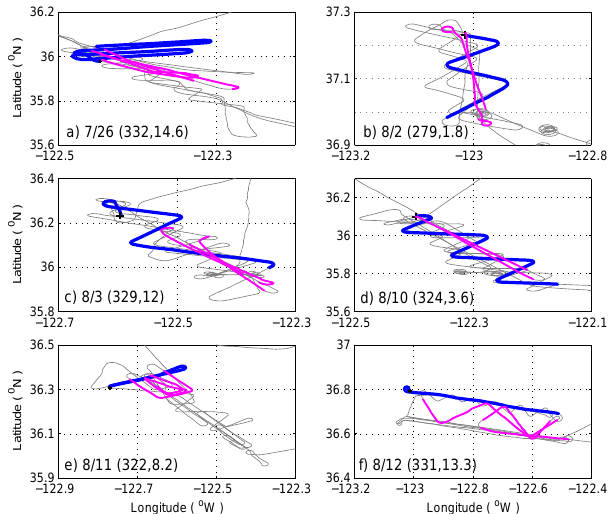
Figure A1. Flight patterns during salt seeding (blue) and post- seeding cloud sampling legs (magenta) for some of the seeding flights. First and second numbers inside the parentheses indicate the mean wind direction (degree) and mean wind speed (ms − 1 ) during the salt-seeding leg,